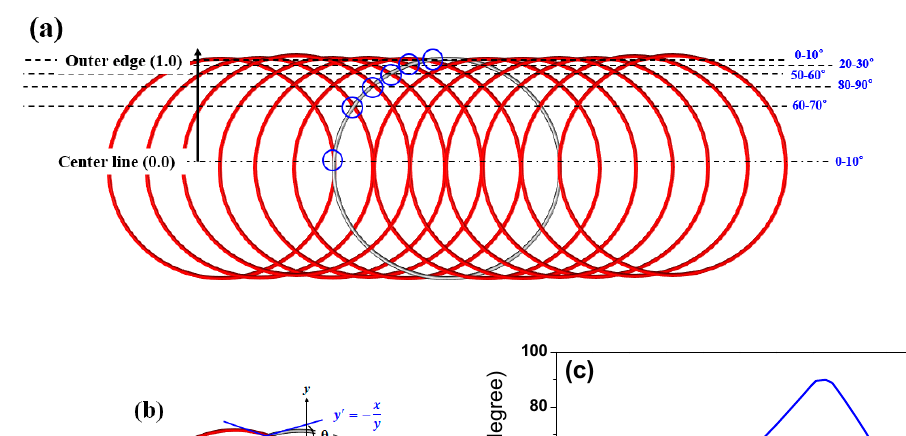
Figure 12. Calculated hotspot indicator as a function of ( a ) wire diameter and ( b ) both wire diameter and contact angle.